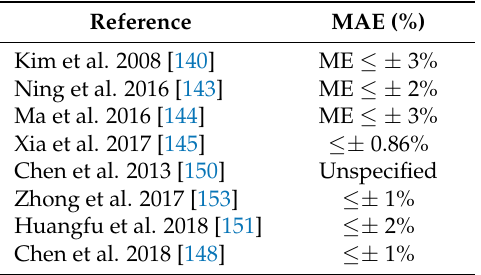
Table 13. MAE/ME of the SMO-based SOC estimation